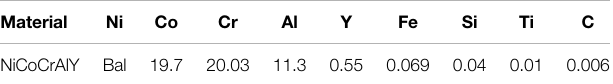
TABLE 1 | Chemical compositions of the powder